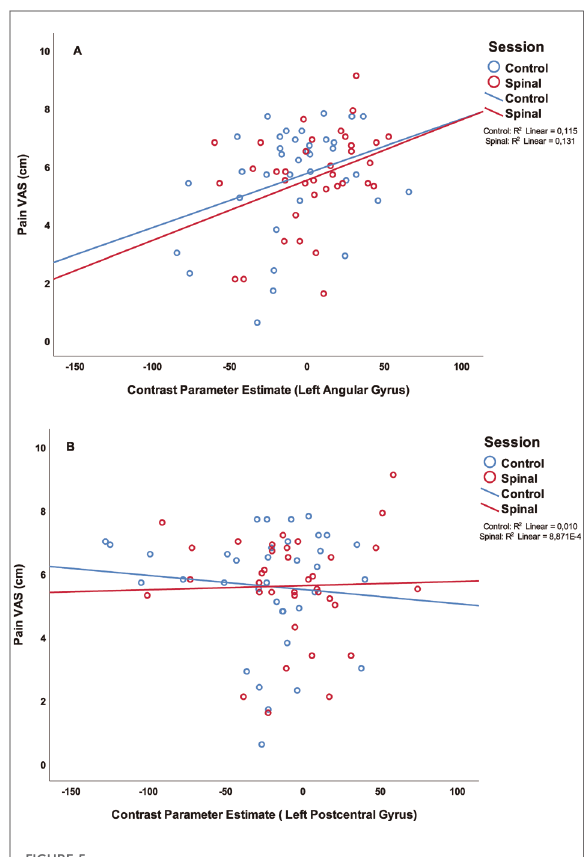
FIGURE 5 Scatterplot of the painscore (VAS in cm) and parameter estimates of ( A ): the peak voxel of the left angular gyrus, part of the IPL (X= − 52, Y= − 58, Z=48 ( B ): the peak voxel of the left postcentral gyrus (X= − 60, Y= − 22, Z=46). In blue the scores of the control session in red the scores of the spinal